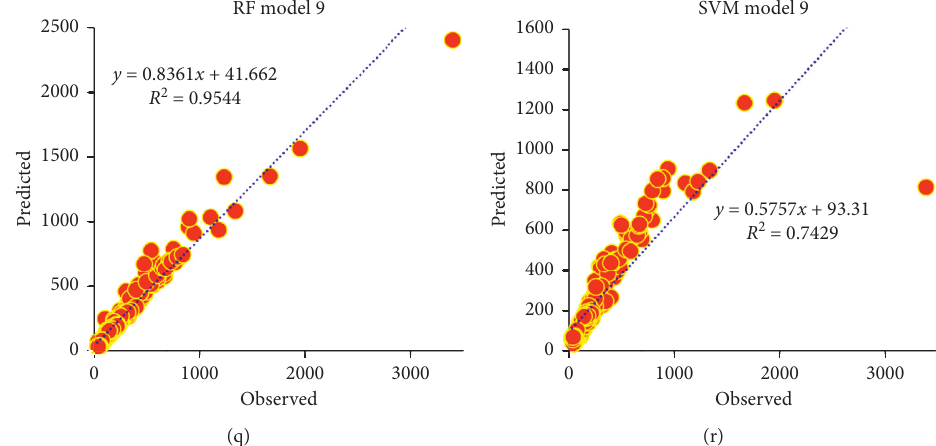
Figure 6: The scatter plots of the RF and SVM models over the training phase for all investigated input